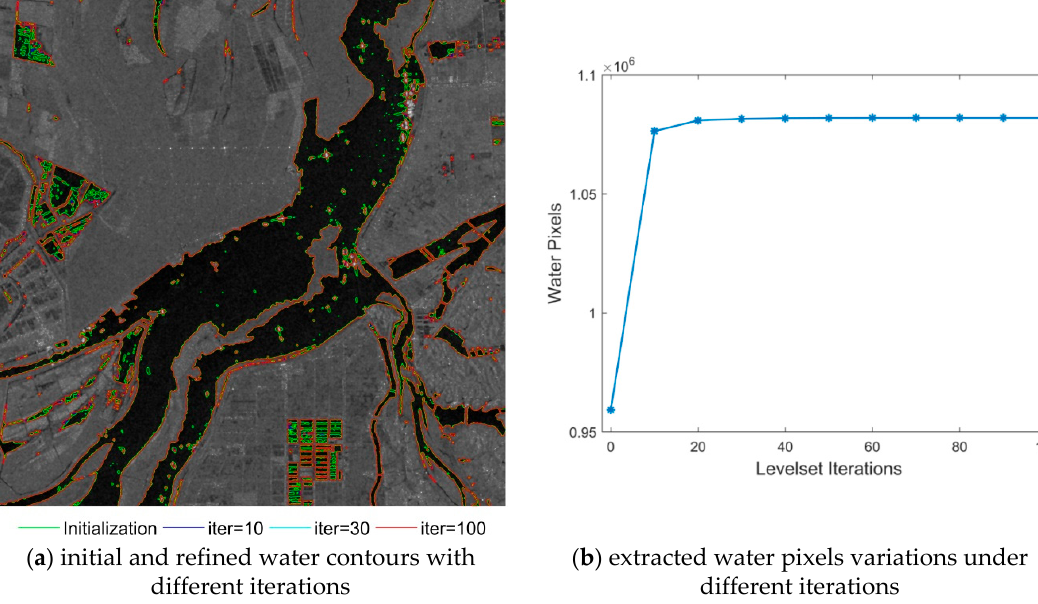
Figure 9. The refinement of initial thresholding results and extracted water pixels varying under different iterations.